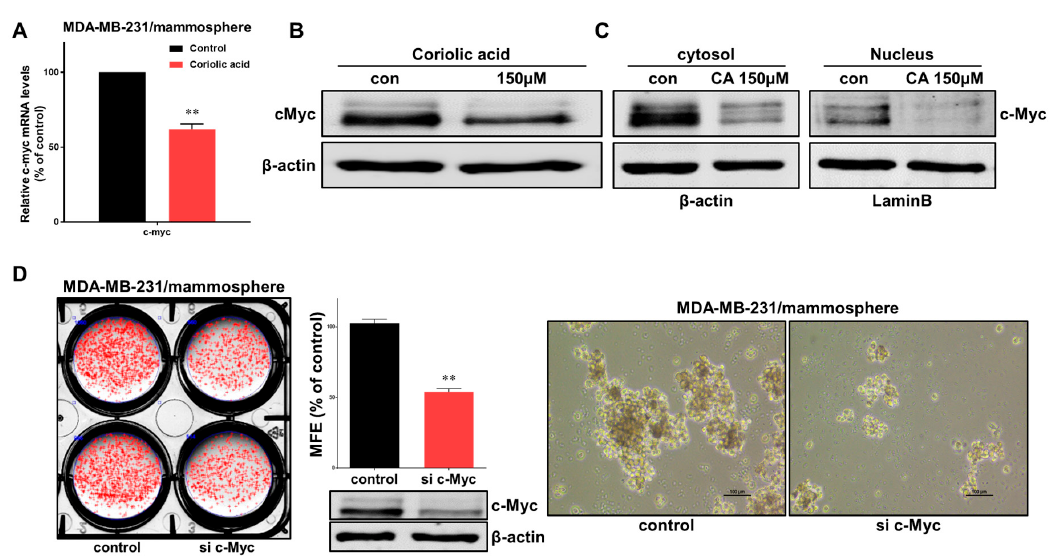
Figure 6. Coriolic acid regulates c-Myc mRNA and c-Myc protein levels. ( A ) Transcripts level of c-myc genes in CSCs was measured in mammospheres with/without coriolic acid treatment using c-myc primers and real-time PCR (Table S1). β -Actin was used as an internal control. ( B ) The total protein level of c-Myc was assayed in MDA-MB-231 cell mammospheres after treatment with coriolic acid (0 or 150 µM) for 1 day using immunoblotting. Total lysates were used to analyze immunoblots with an anti-c-Myc antibody. β -Actin was used as an internal control. ( C ) After treatment with coriolic acid for 48 h, the protein levels of c-Myc in the cytosolic and nuclear fractions were analyzed in mammospheres using western blotting. Nuclear and cytosolic proteins were separated on SDS-PAGE gels, followed by immunoblotting with anti-c-Myc, anti- β -actin, and anti-lamin B antibodies. ( D ) E ff ects of the c-Myc protein on mammosphere formation using siRNA targeting c-Myc. C-Myc-downregulated MDA-MB-231 cells were cultured for 8 days. Images were obtained by inverted light microscopy at 10 × magnification. Data are presented as the mean ± SD of three independent experiments. ** p < 0.01 vs. the DMSO-treated control group.